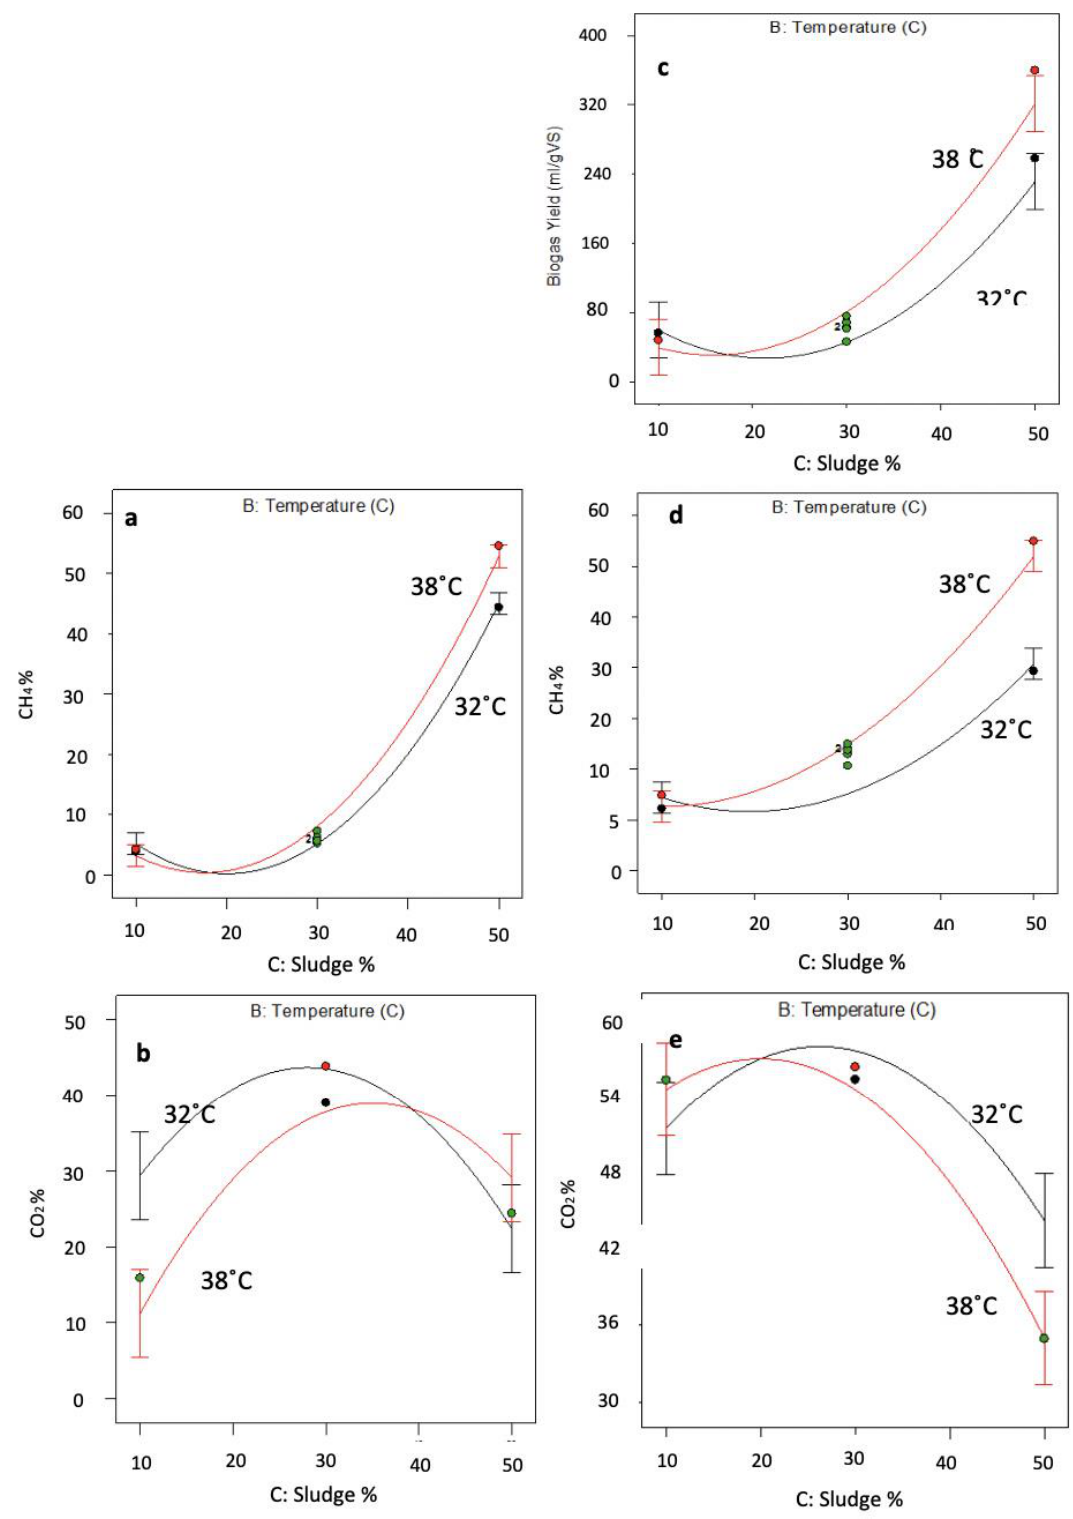
Figure 10. Interaction graphs for AD of pot ale and spent grain and pot ale mix on CH 4 % ( a , d ) and CO 2 % ( b , e ) respectively and on biogas yield by AD of pot ale spent grain ( c ).